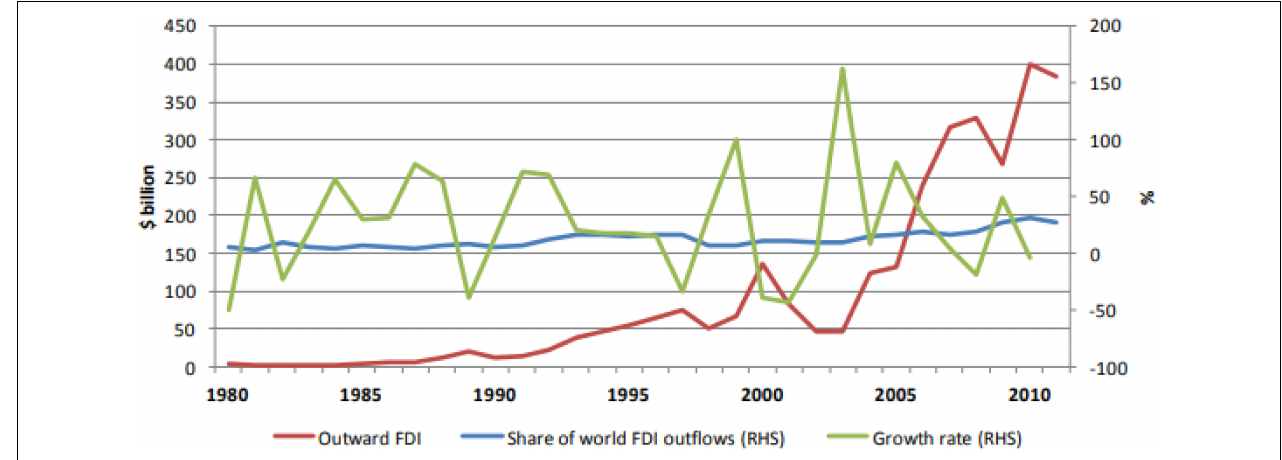
FIGURE 1 | Trend of Outward FDI in Developing Economies from 1980 to 2011(UNCTAD, 2012; Al-sadiq,